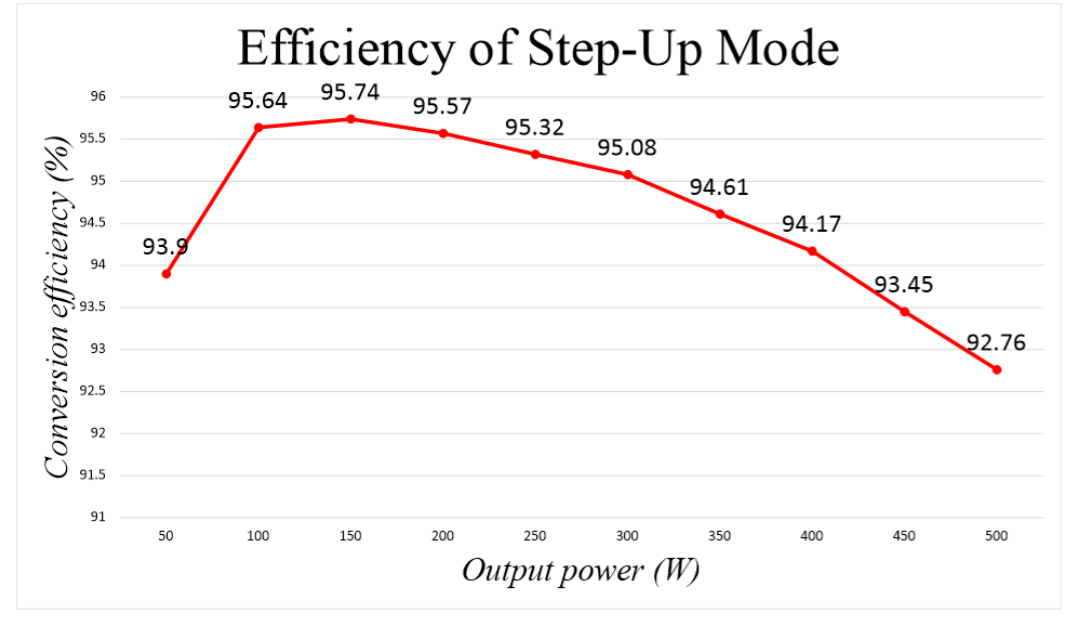
Figure 17. Energy conversion efficiency curve of the proposed topology in the step-up mode.